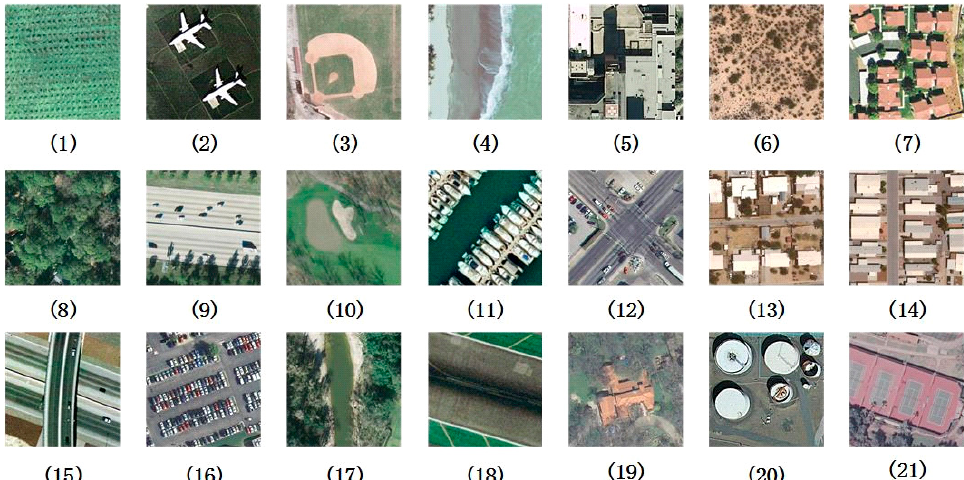
Figure 7. Examples from the 21-class land-use dataset: ( 1 ) agricultural; ( 2 ) airplane; ( 3 ) baseball diamond; ( 4 ) beach; ( 5 ) buildings; ( 6 ) chaparral; ( 7 ) dense residential; ( 8 ) forest; ( 9 ) freeway; ( 10 ) golf